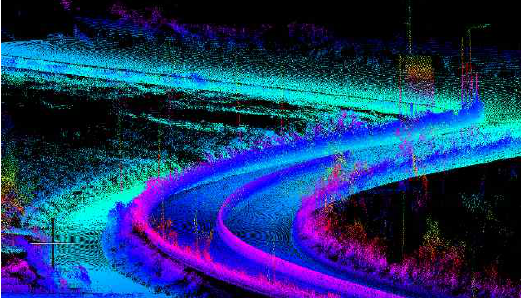
Figure 5. Point cloud data generated by